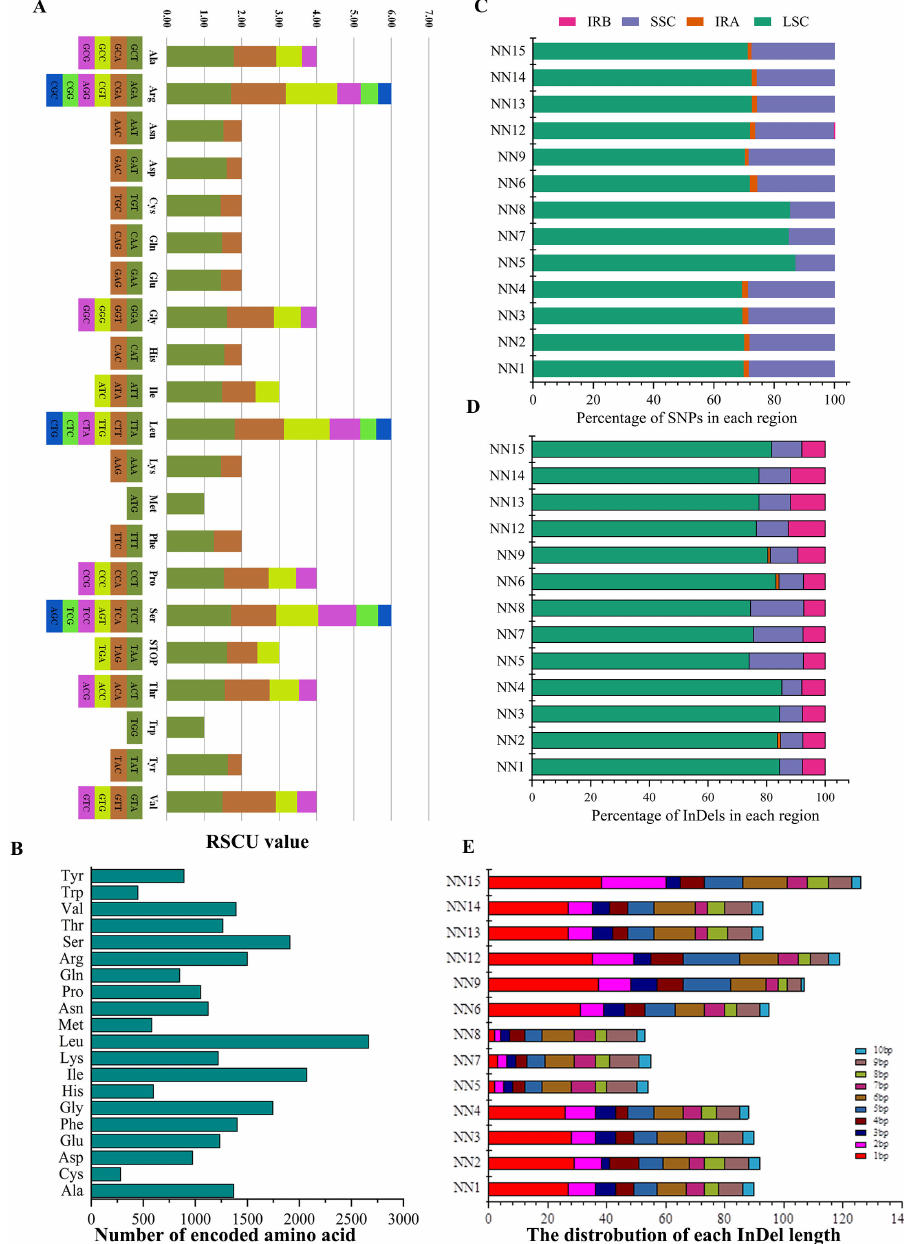
Figure 2. Codon, amino acid and sequence variation analyses of the cp genome. ( A ) Codon content and RSCU value of 20 amino acids and the stop codon of NN1 ( Solanum aethiopicum L. ) cp genome. ( B ) Numbers of encoded amino acids of NN1 cp genome. ( C , D ) Percentage of SNPs and InDels in each region. ( E ) The distribution of InDel